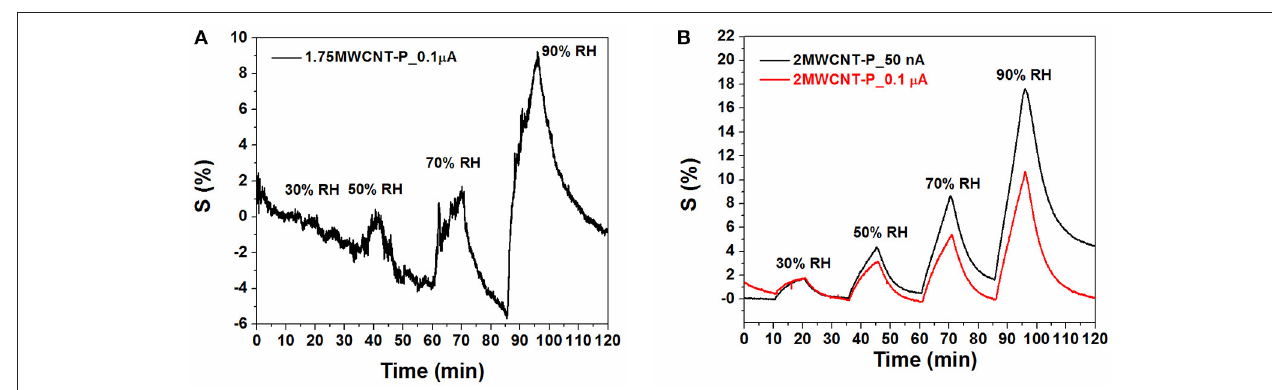
0.1mm) of (A) SEBS-MA-PEG/1.75MWCNT-P and (B) ∼